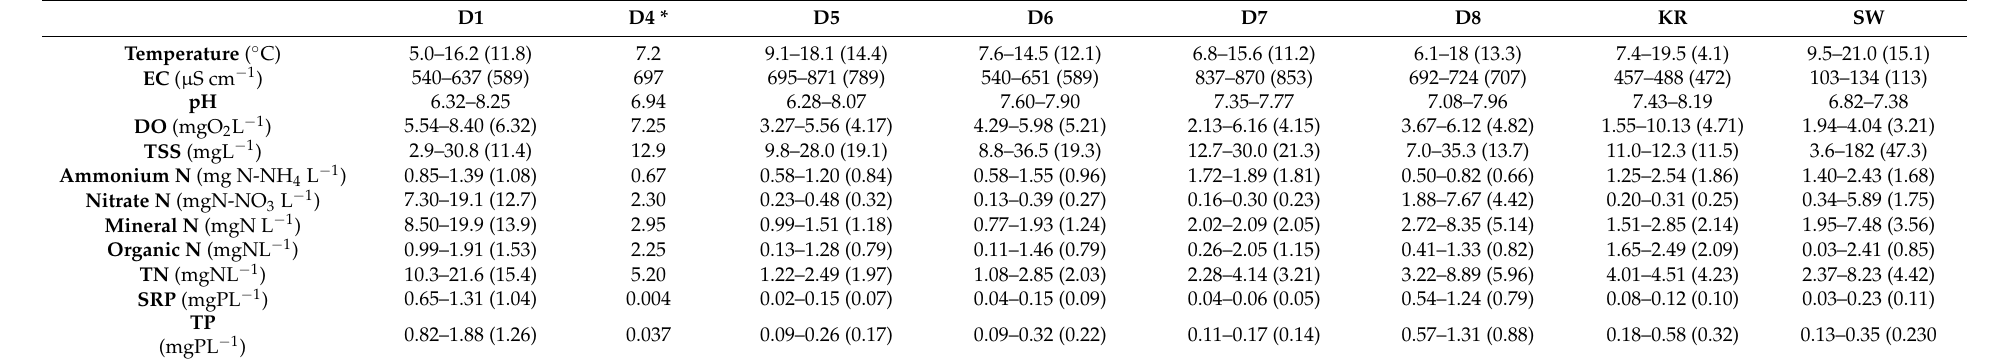
Table 2. Minimum, maximum and mean value of parameters in the inflows (D1–D8), outflow (KR) and stormwaters (SW) (*—only one